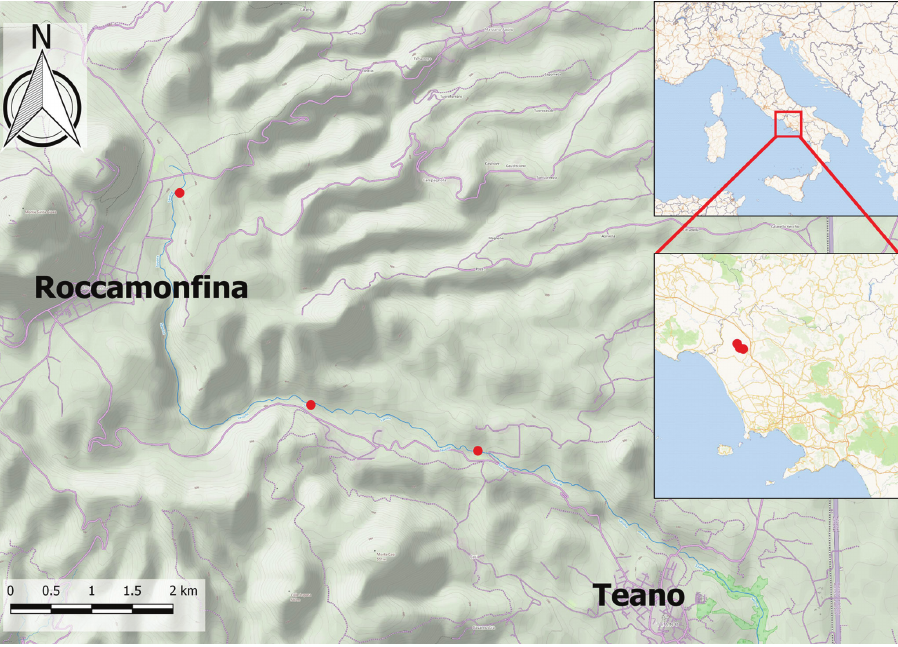
Figure 2. Geographic range and distribution map of Epipactis maricae